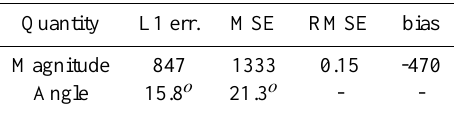
Table 1. Long motion error statistics: the magnitude errors (except the RMSE) are in meters.